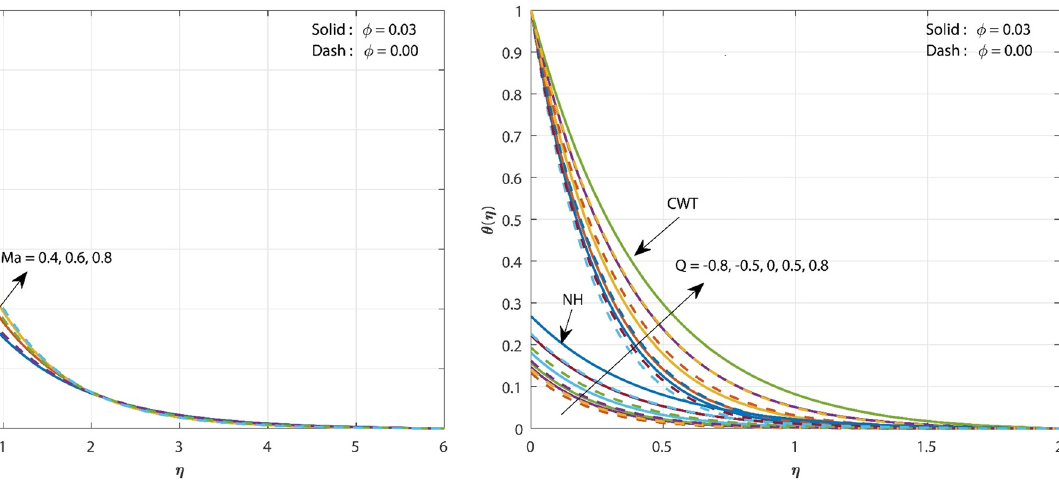
Figure 5: Plot of θ ( η ) over di ff erent values of Q .